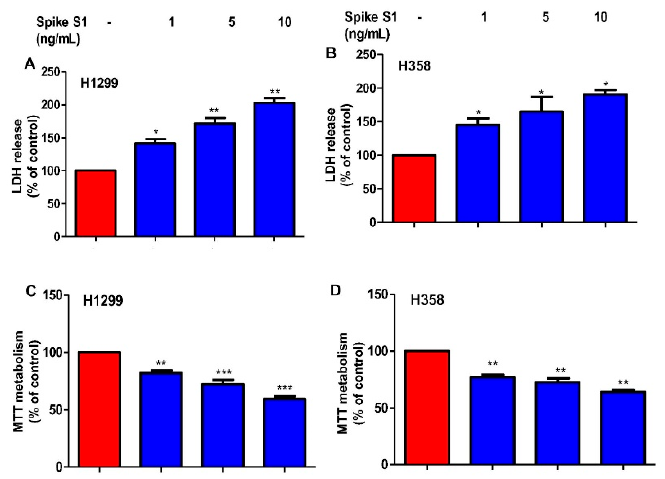
Figure 6. Effect of recombinant SARS-CoV-2 spike S1 on the survival of human H1299 and H358 lung cancer cells. H1299 ( A , C ) and H358 ( B , D ) cells were treated with spike S1 protein for 24 h under serum-free condition followed by monitoring cell death by LDH release ( A , B ) and MTT ( C , D ). Results are mean + SD of three different experiments. * p < 0.05; ** p < 0.01; *** p < 0.001.